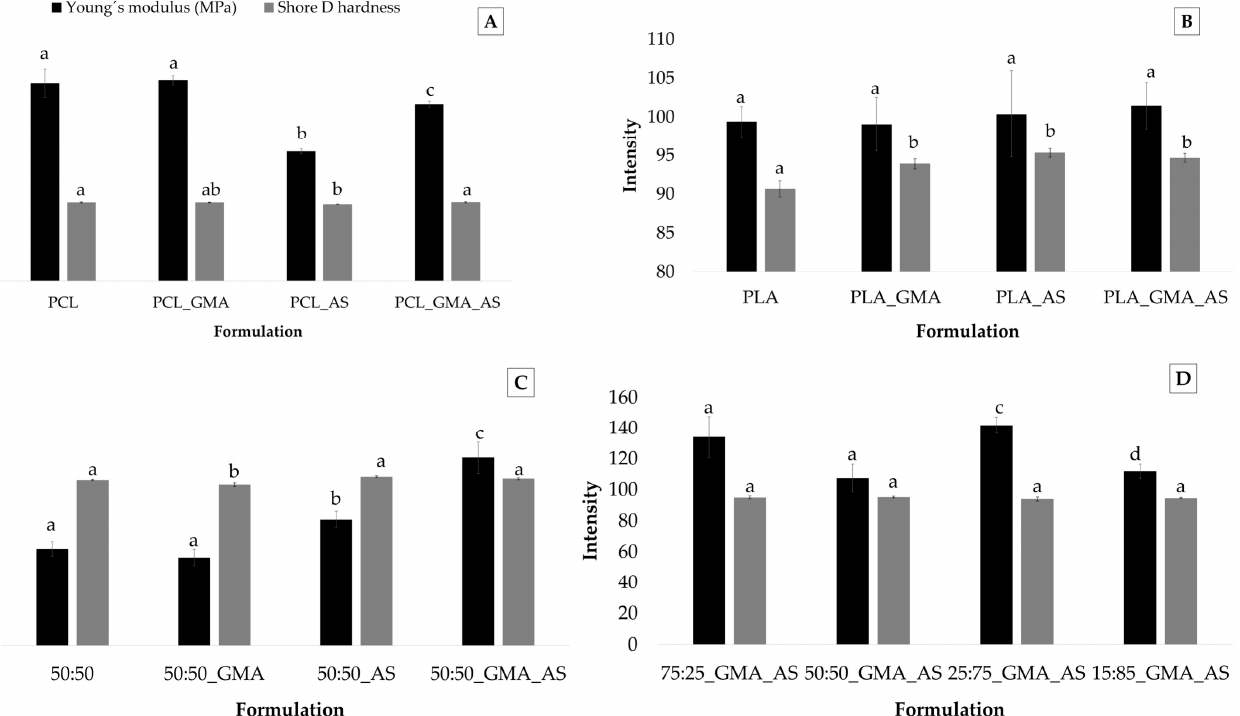
Figure 2. Young´s modulus ( n = 5) and Shore D hardness ( n = 3) values for PCL controls ( A ), PLA controls ( B ), PCL/PLA (50:50) controls ( C ), and PCL/PLA formulations ( D ). Mean ± SD. Different superscripts within the same parameter indicate statistically significant different values ( p < 0.05). Young´s modulus values ranged from 50 ± 9 MPa for 50:50_GMA to 244 ± 5 MPa for